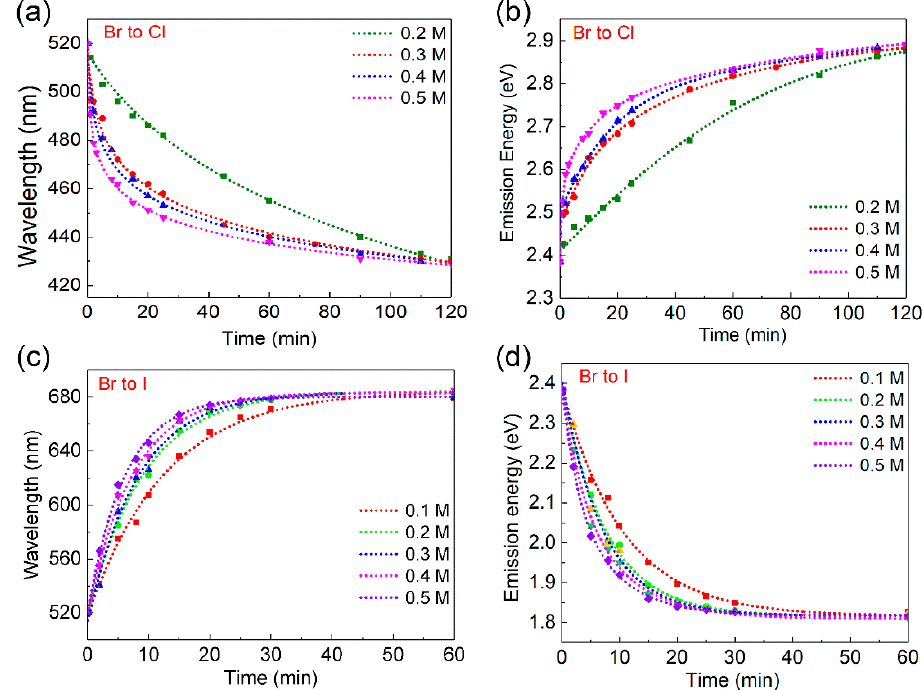
Figure 4. ( a ) PL wavelength and ( b ) emission peak energies of samples that were prepared by the Cs 4 PbBr 6 n-hexane dispersion reaction with various concentrations (0.2 M ~ 0.5 M) of KCl aqueous solution. ( c ) PL wavelength and ( d ) emission peak energies of samples that were prepared by the Cs 4 PbBr 6 n-hexane dispersion reaction with various concentrations (0.1 M ~ 0.5 M) of KI aqueous solution.